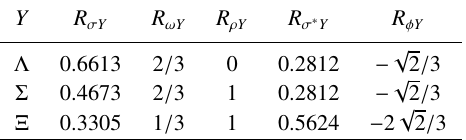
their ratios to the corresponding couplings of nucleons: R iY = g iY /g iN for i = ( σ, ω, ρ ),